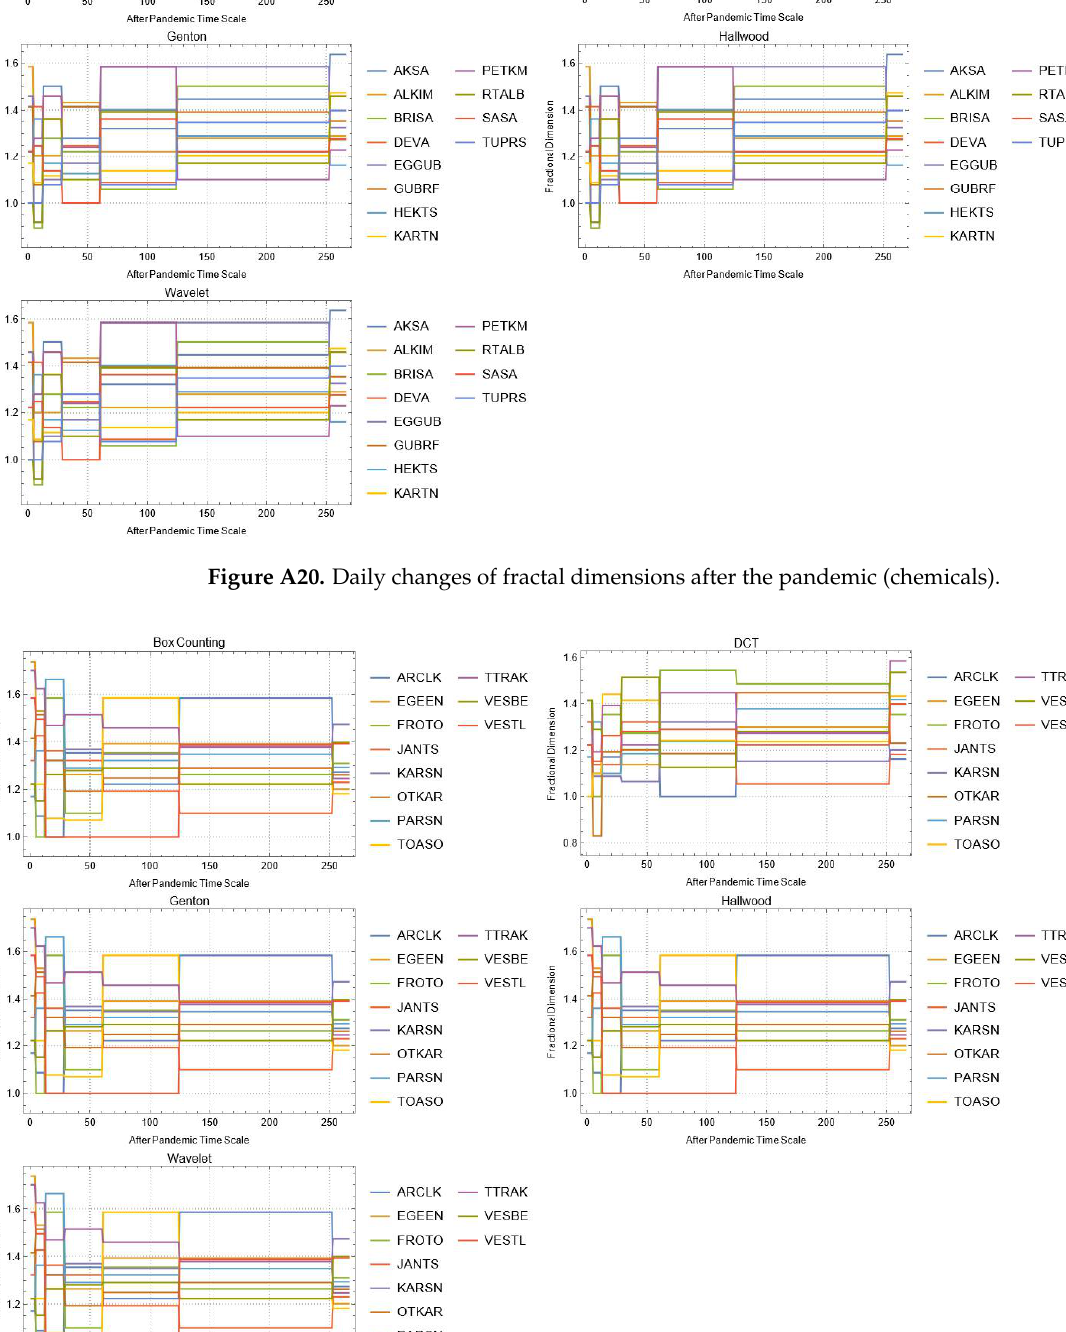
Figure A21. Daily changes of fractal dimensions after the pandemic (machineries).